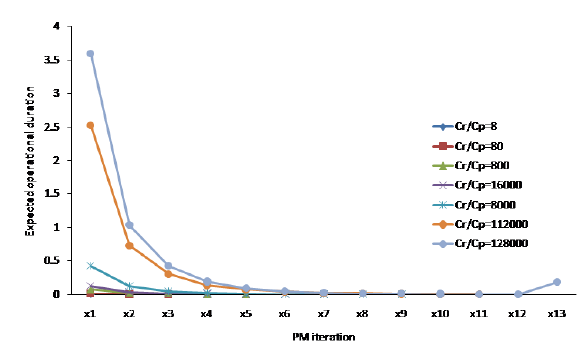
Fig. 5. Optimal PM and replacement schedule simulation for 8HP-PML Gold cassava grinding machine